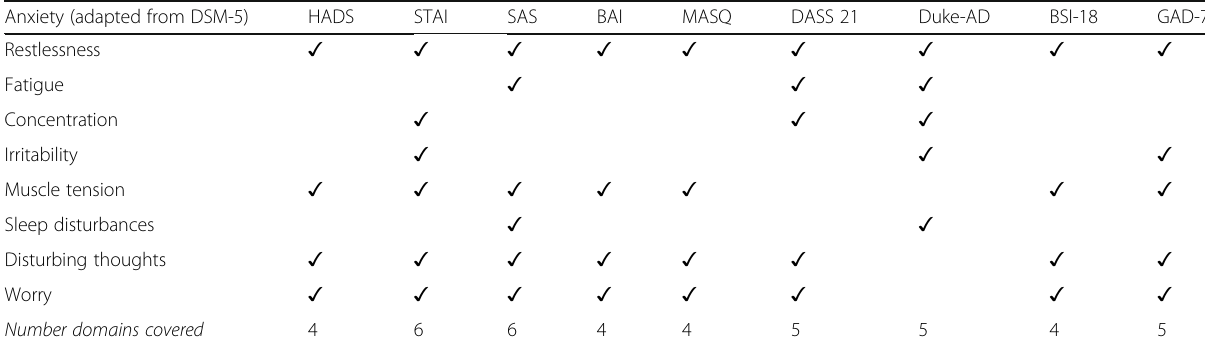
Table 1 Patient reported outcome measures of anxiety: content mapping Anxiety (adapted from DSM-5)